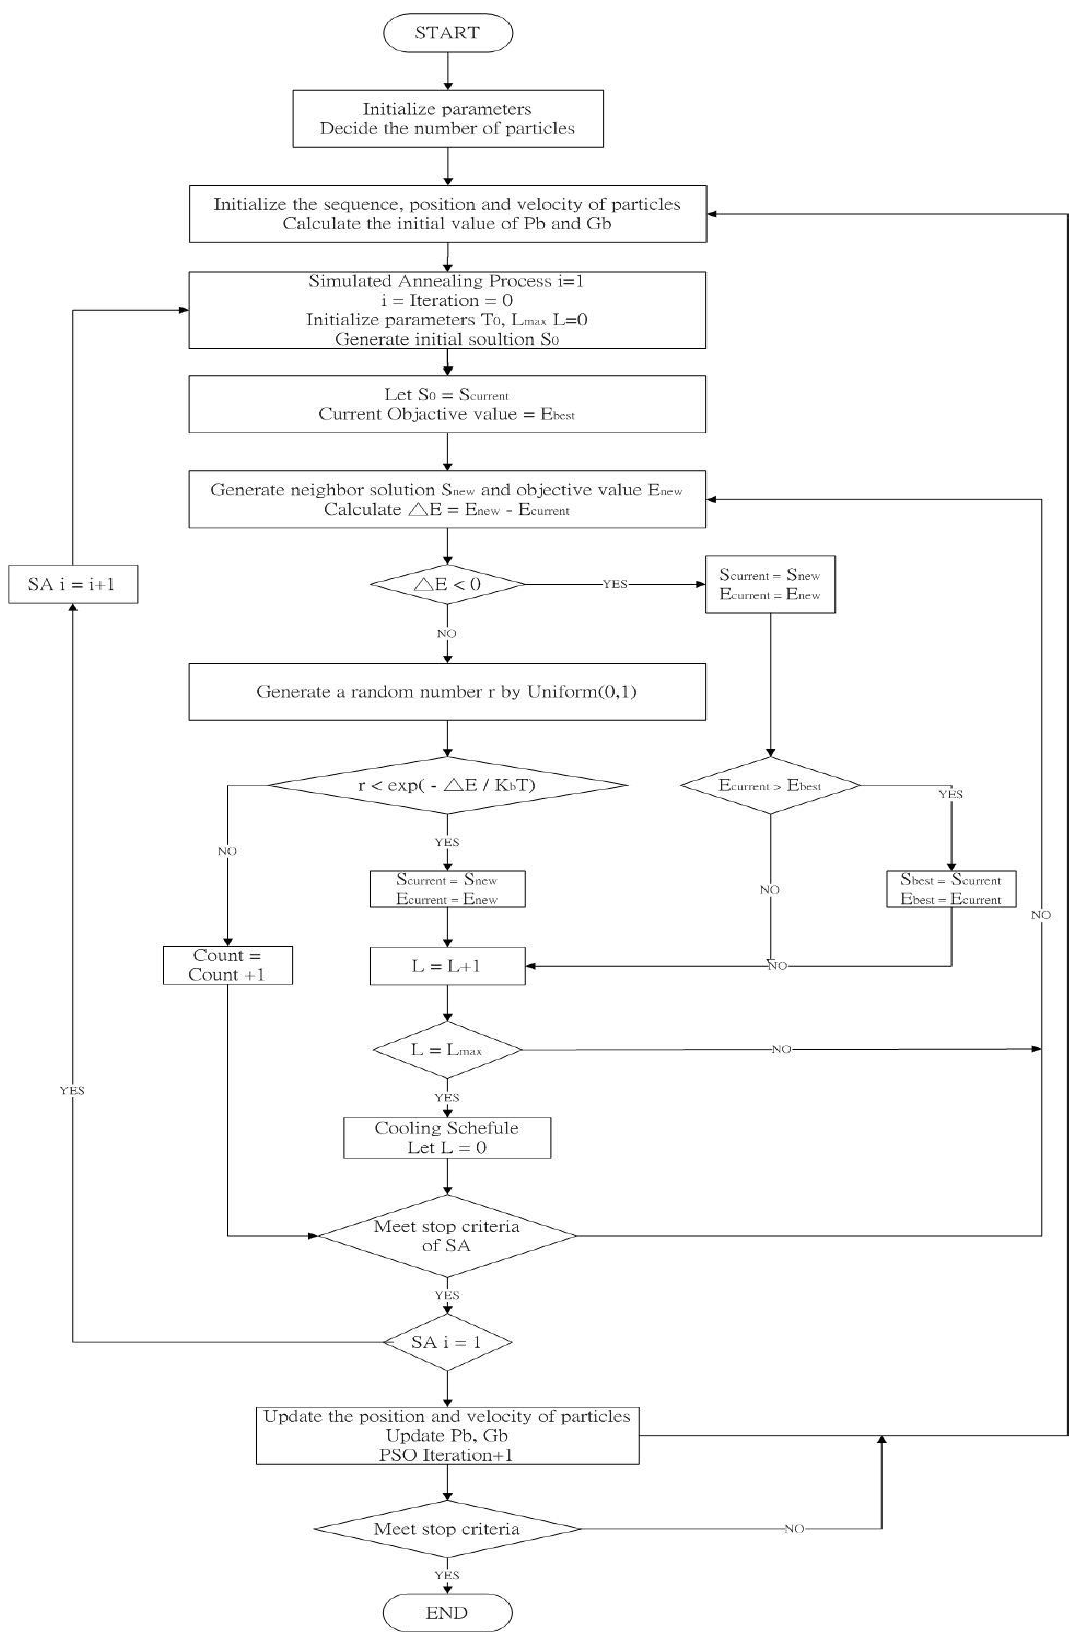
Figure 7. PSO + SA + SA.